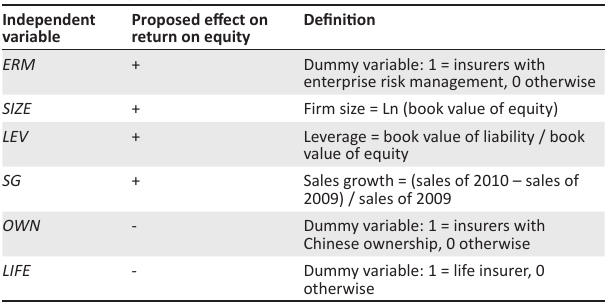
TABLE 3: Summary of independent variables. Independent Proposed effect on variable return on equity